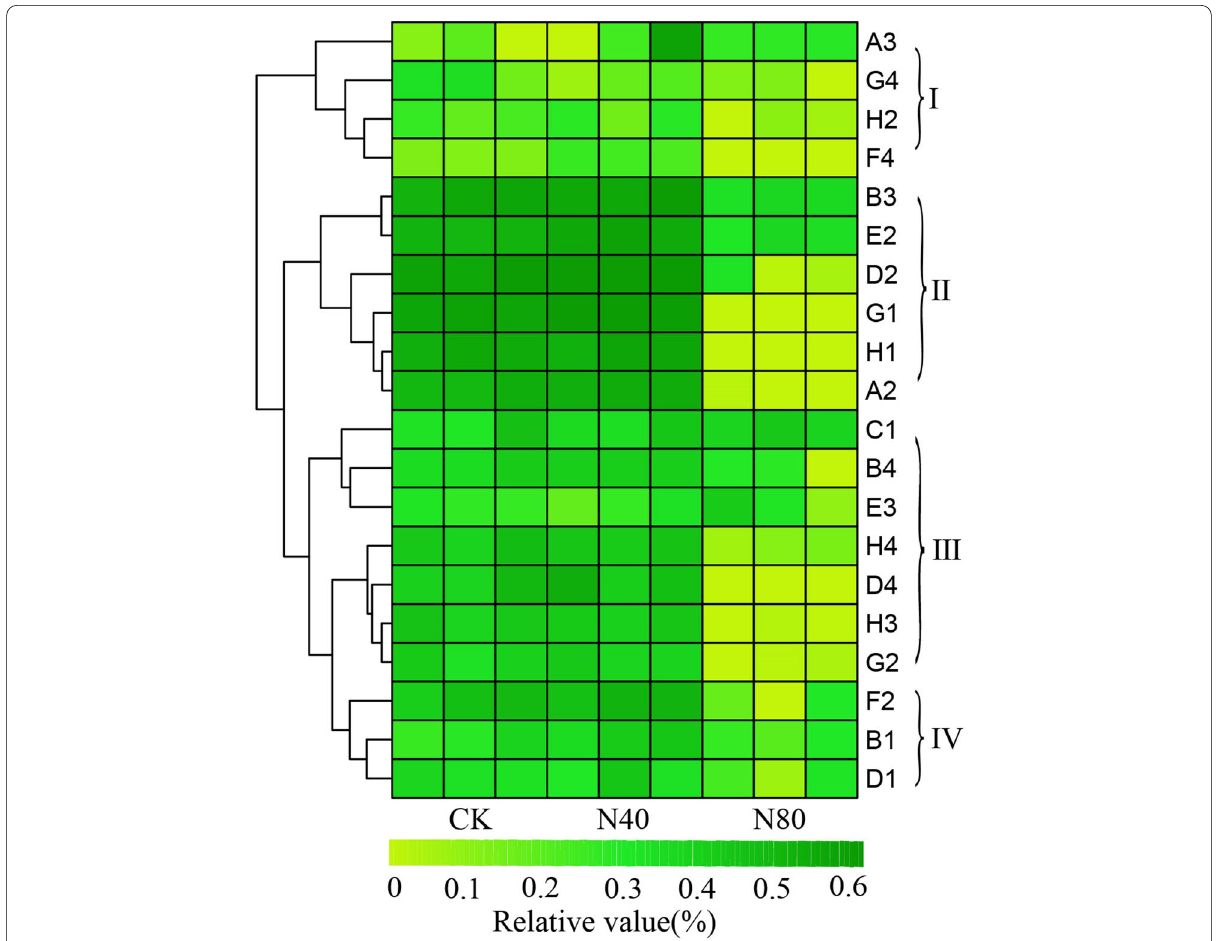
Fig. 4 Heat map and hierarchical cluster analysis based on the average well color development (AWCD) at 120 h of soil microbial communities under different nitrogen addition treatments. The samples are grouped based on their similarity to each other. The clustering results are arranged horizontally. Higher AWCD values are indicated in dark green, whereas lower AWCD values are indicated in yellow. CK, control; N40, 40 kg N ha −